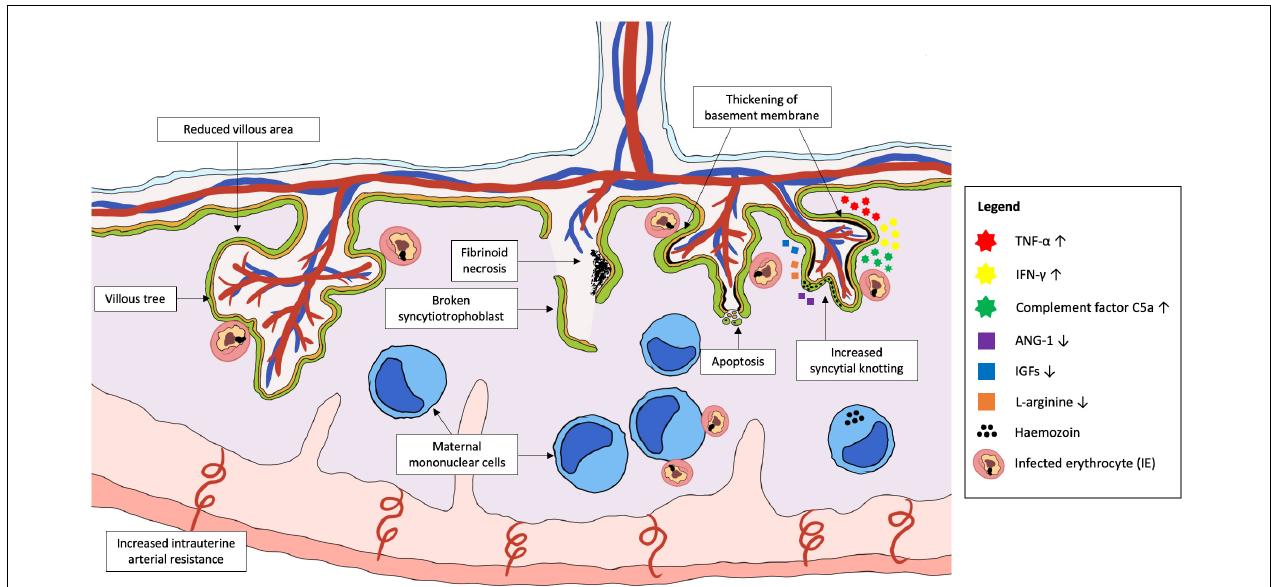
FIGURE 2 | Plasmodium parasite infection in the placenta that cause abnormal placental development and damage. Placental malaria is an infection in the placenta by Plasmodium spp., commonly P. falciparum . Emerging evidence suggests that pregnant women are at the highest risk of PM in the first trimester, which coincides with the period of placental growth and development. Abnormalities in the placenta during PM include permanent damage to placental structures such as broken syncytiotrophoblast, thickening of basement membrane, increased syncytial knotting, increased areas of fibrinoid necrosis and dysregulated apoptosis of trophoblasts. This can result in placental insufficiency that contributes to the increased risk of fetal growth restriction, low birth weight and pre-eclampsia. The pathology is mainly associated with the activation of a local inflammatory response, characterized by the accumulation of activated maternal mononuclear cells within the intervillous spaces. The subsequent pathways leading to placental pathologies include the increased production of pro-inflammatory cytokines, chemokines, and complement proteins, as well as reduced levels of important angiogenic and placental growth factors. Together, these factors may disrupt the development of placenta if infection takes place early in pregnancy, leading to shallow spiral artery development and increased intrauterine arterial resistance.